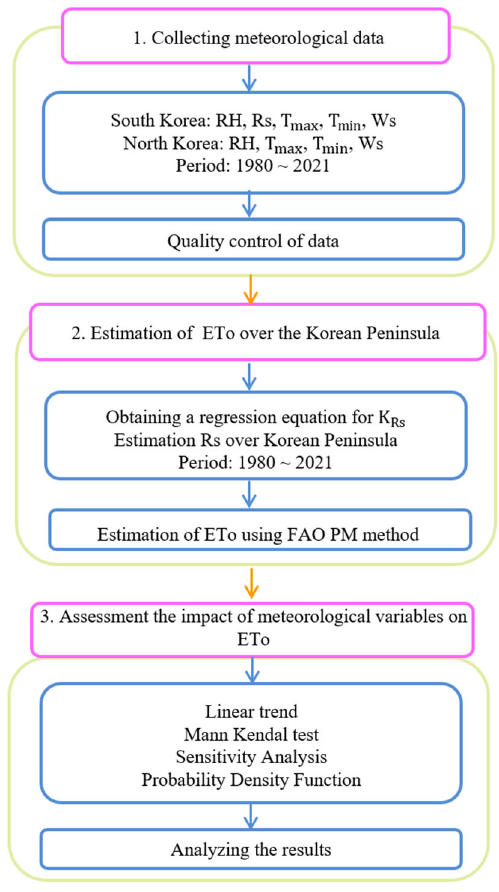
Figure 2. Workflow diagram.